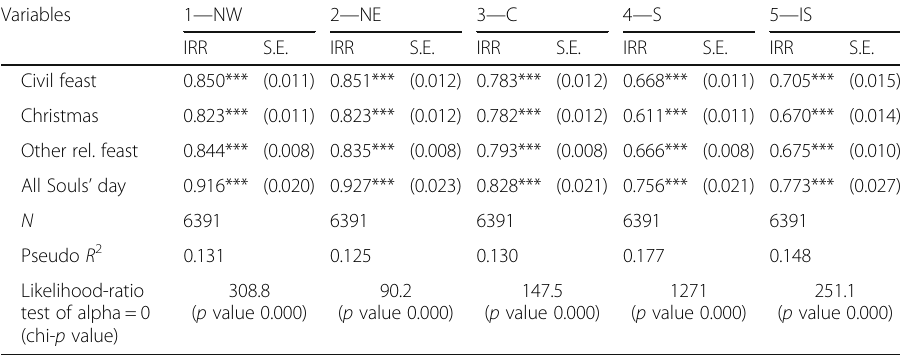
Table 2 The calendar effect on the daily male births, Italian macro-areas 1 January 1999 to 30 June 2016 (Continued)